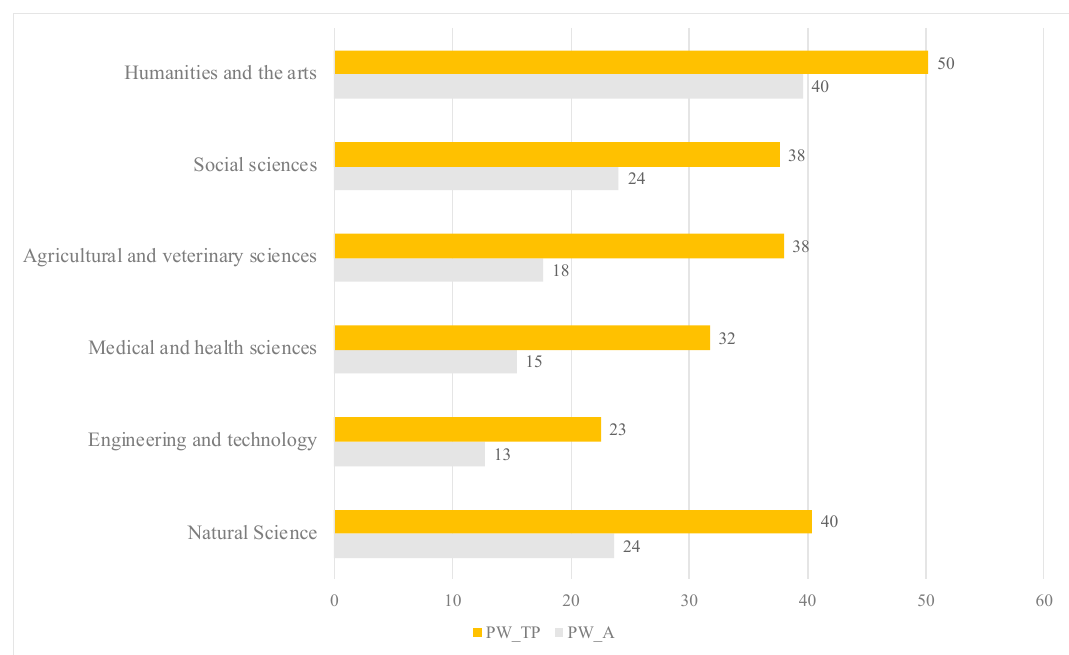
Figure 3. Proportions (%) of women in fixed-term positions and at the recruitment stage by main field of science (the author’s elaboration on MIUR data, 2017).